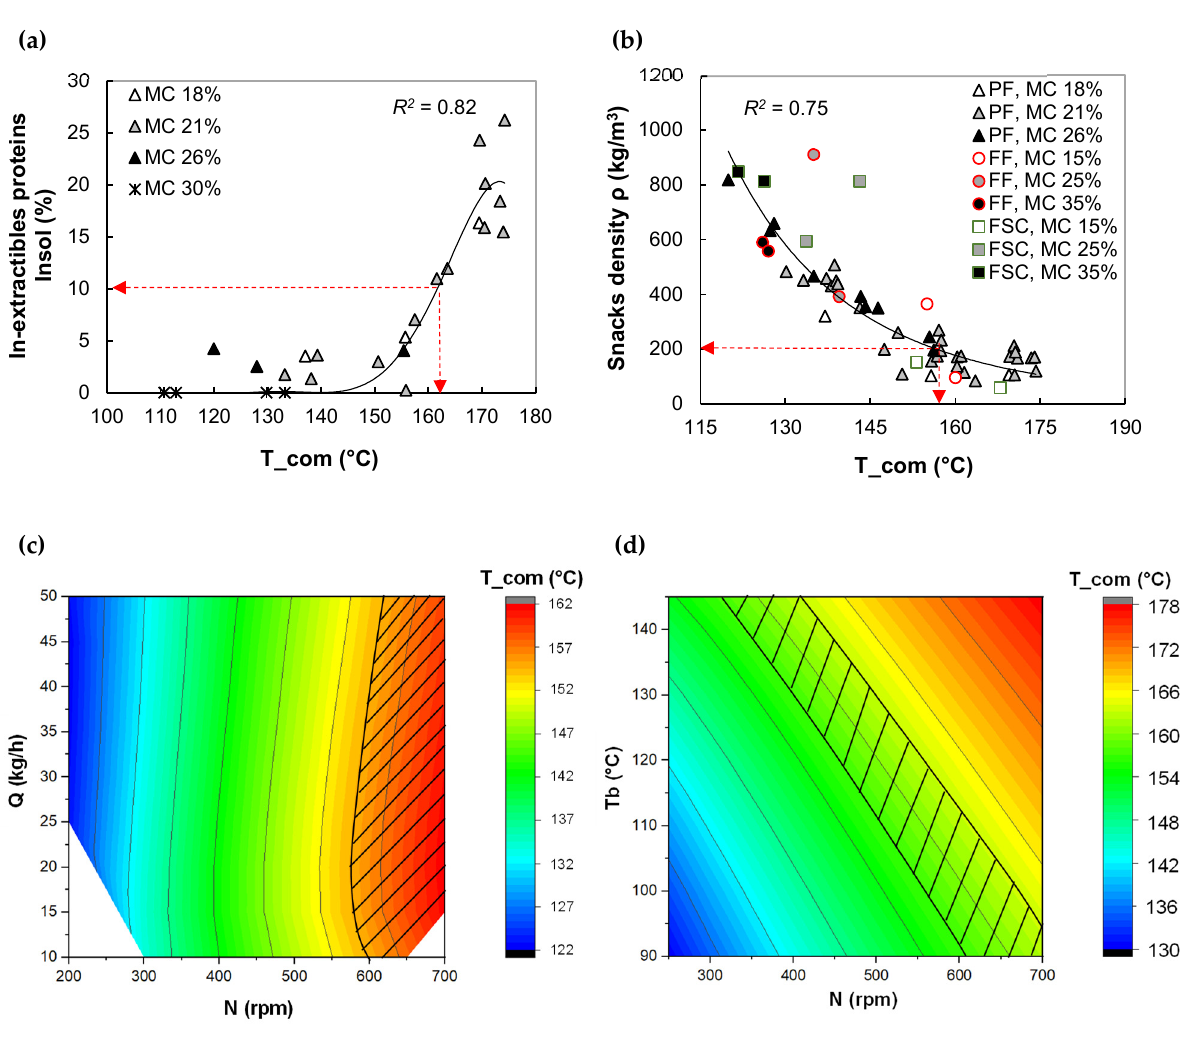
Figure 7. Application of extrusion simulation in the design of pea snacks. Step 1. Variation of in-extractible proteins ( a ) and density ( b ) of snacks with T_com. The arrows indicate the upper limits of targeted T_com and snack properties. Step 2. Creation of extruder operating chart by the 1D extrusion model and determination of the range of extrusion conditions (Q, N, Tb), delimited with a hatched area, leading to predicted melt temperature between 155 and 165 ◦ C according to the goals: snack density <200 kg/m 3 , and protein structural change: insoluble proteins <10% for feed moisture contents of 21% ( c , d